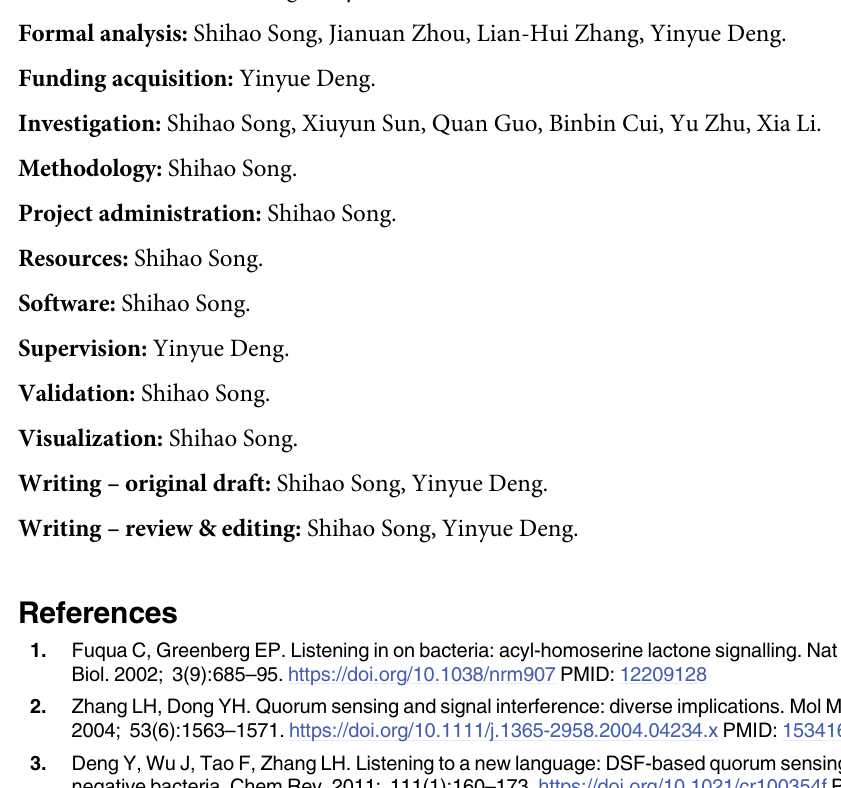
S2 Table. List of genes differentially expressed in the trpEG and raaR mutants compared to the wild-type strain (Log -fold change � 1.5). Significantly differentially expressed genes 2 were determined by Cufflinks after Benjamini-Hochberg correction. The fold-change is the ratio of the mutant FPKM to the wild-type FPKM. S3 Table. Analysis of the homologs of RaaR in various bacteria. S4 Table. Bacterial strains and plasmids used in this study. S5 Table. PCR primers used in this